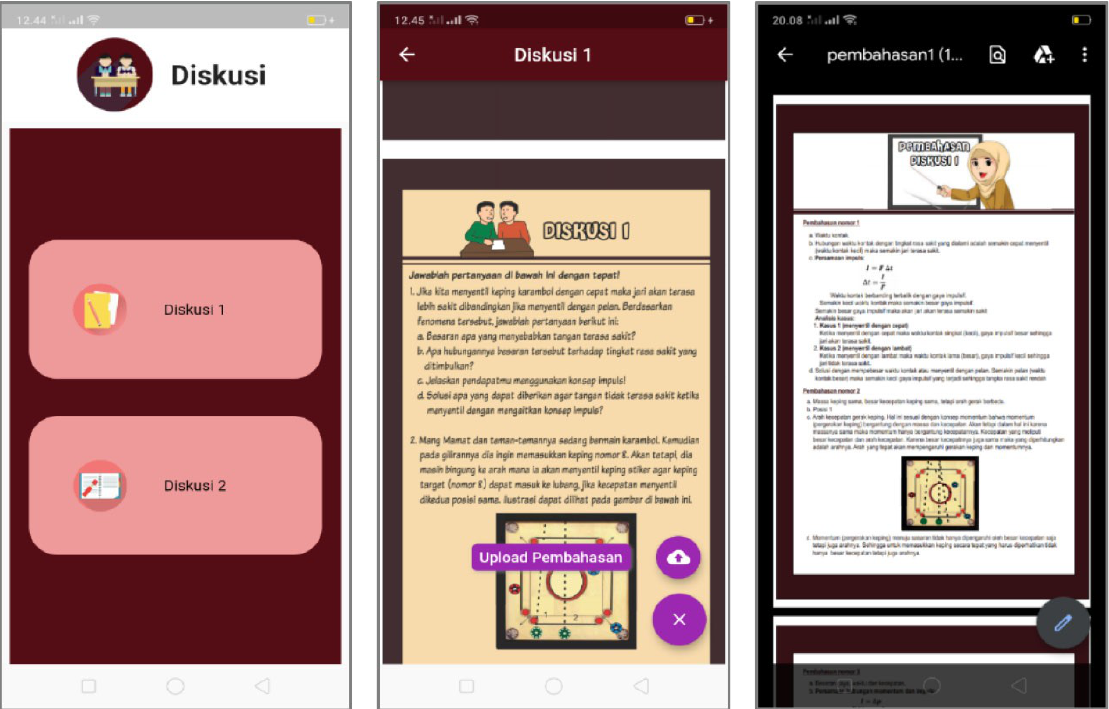
Figure 6. Discussion items containing indicators of critical thinking and mathematical representation